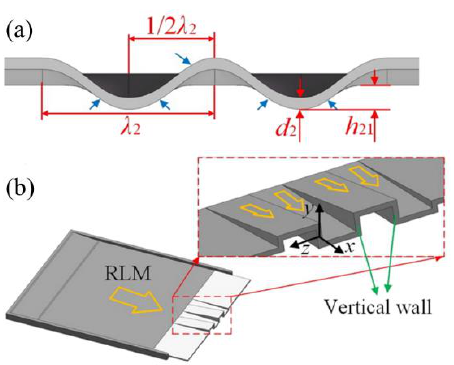
Figure 1. Special shaped baffles. ( a ) Lobed mixer; ( b ) Rectangular lobed mixer